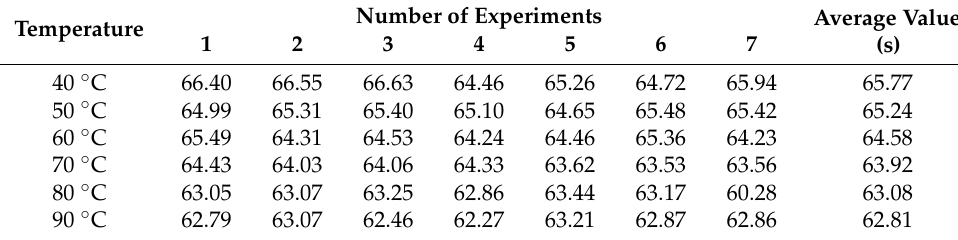
Table 5. Time of bubbles rising in the No. 11 lubricating oil at different temperatures. Number of Temperature